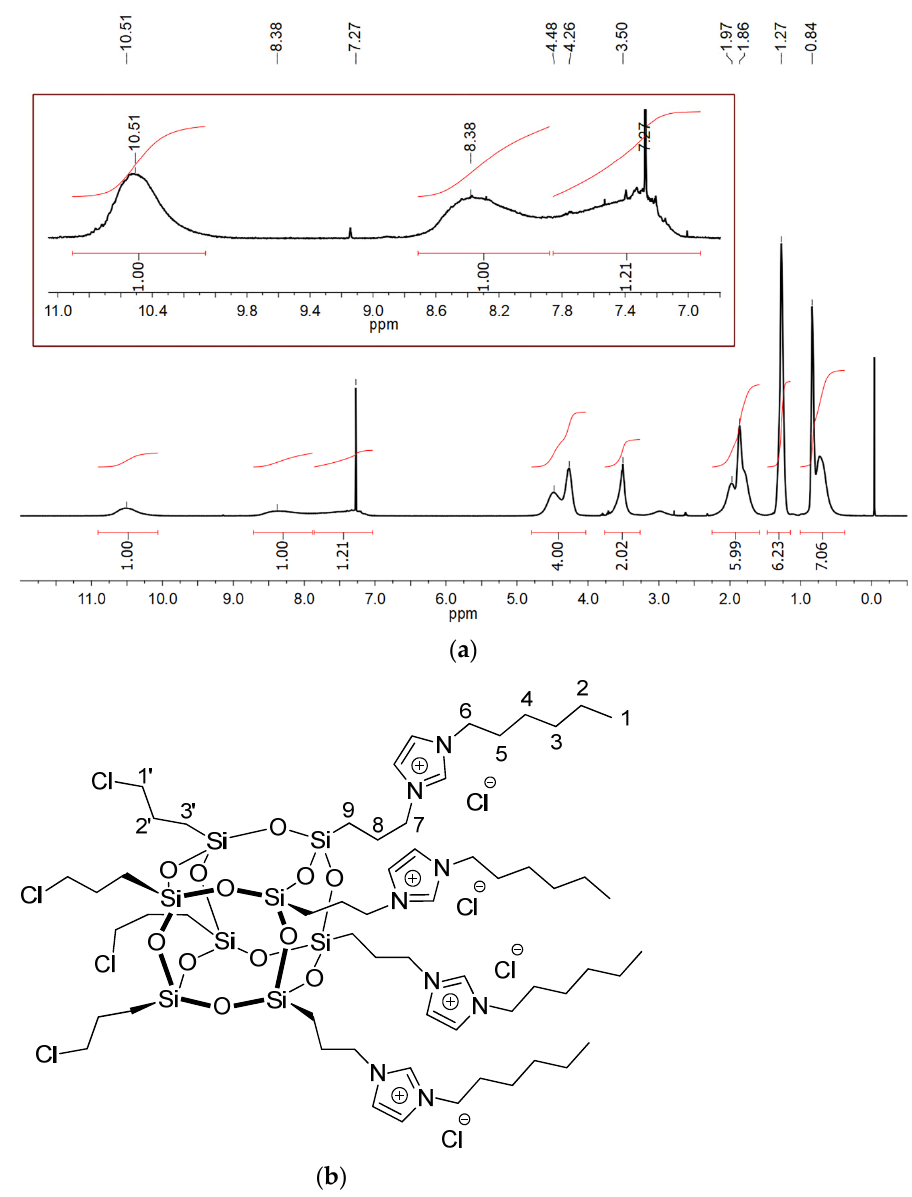
Figure 1. ( a ) The 1 H NMR spectrum of HQ-POSS; ( b ) numbering of carbon atom of HQ-POSS.